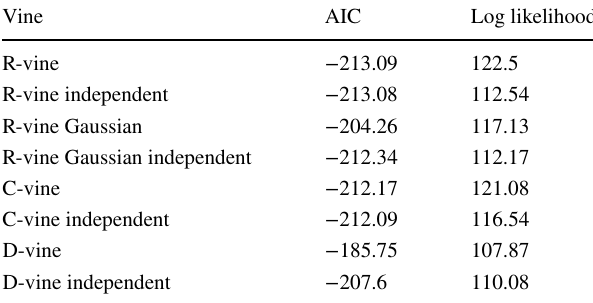
Table 3 The tree structures of the various copulas belonging to